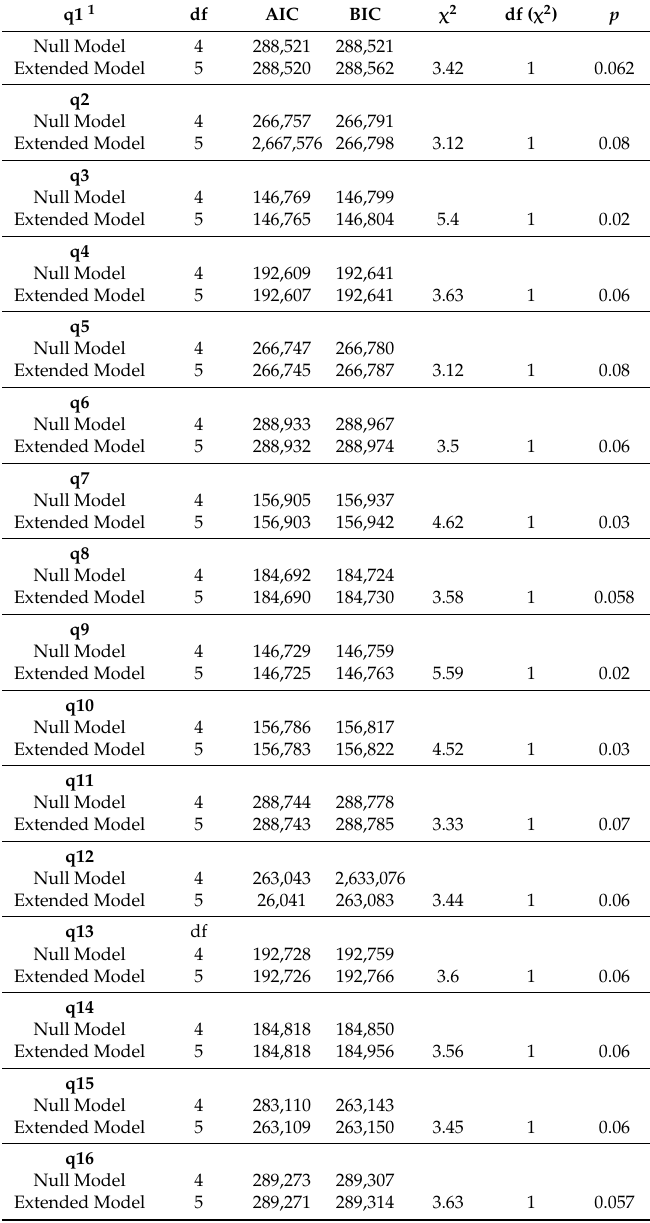
Table A2. Likelihood ratio tests for the null and extended models applied to free parameters in covariance matrix Q